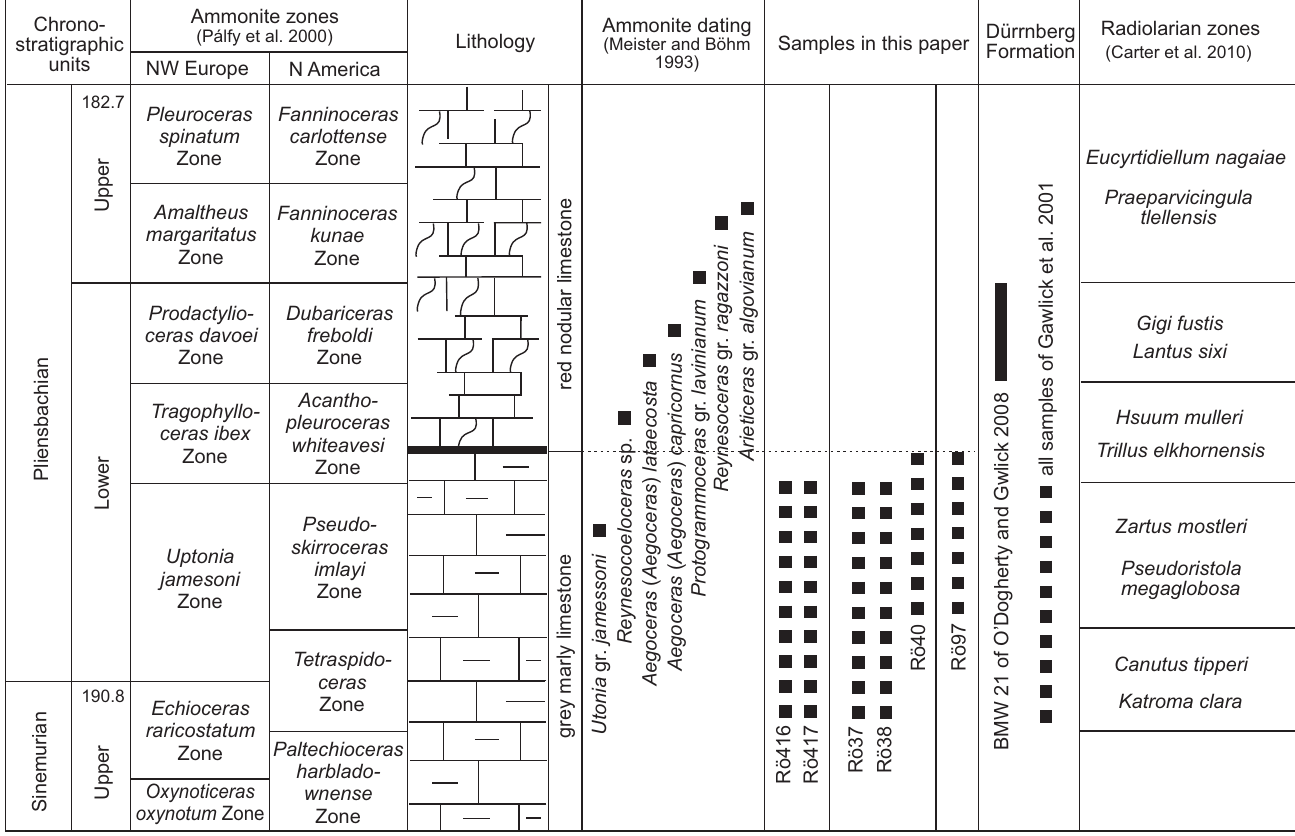
Fig. 11. Combined radiolarian and ammonite dating of Lower Jurassic deposits on Mount Rettenstein. The upper age limit of the grey marly limestone is constrained with ammonites, determined in the overlying red nodular limestone, numerical age after Gradstein et al. (2012). Revised radiolarian dating of samples from the Dürrnberg Formation is shown for